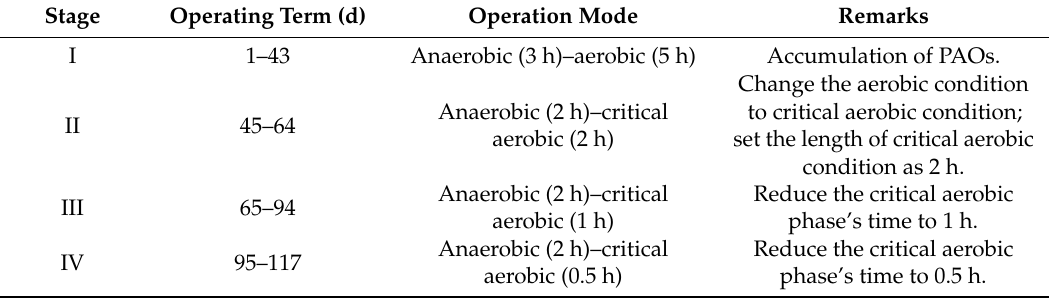
Table 1. The operating mode of the pilot SBR at low temperature of synthetic wastewater. PAO— phosphorus accumulating organisms.